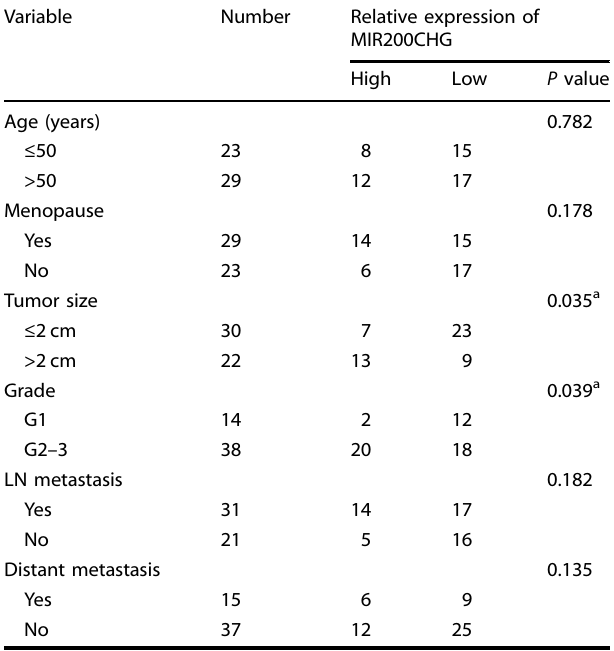
Table 1. Relationship between MIR200CHG expression and pathological features in breast cancer